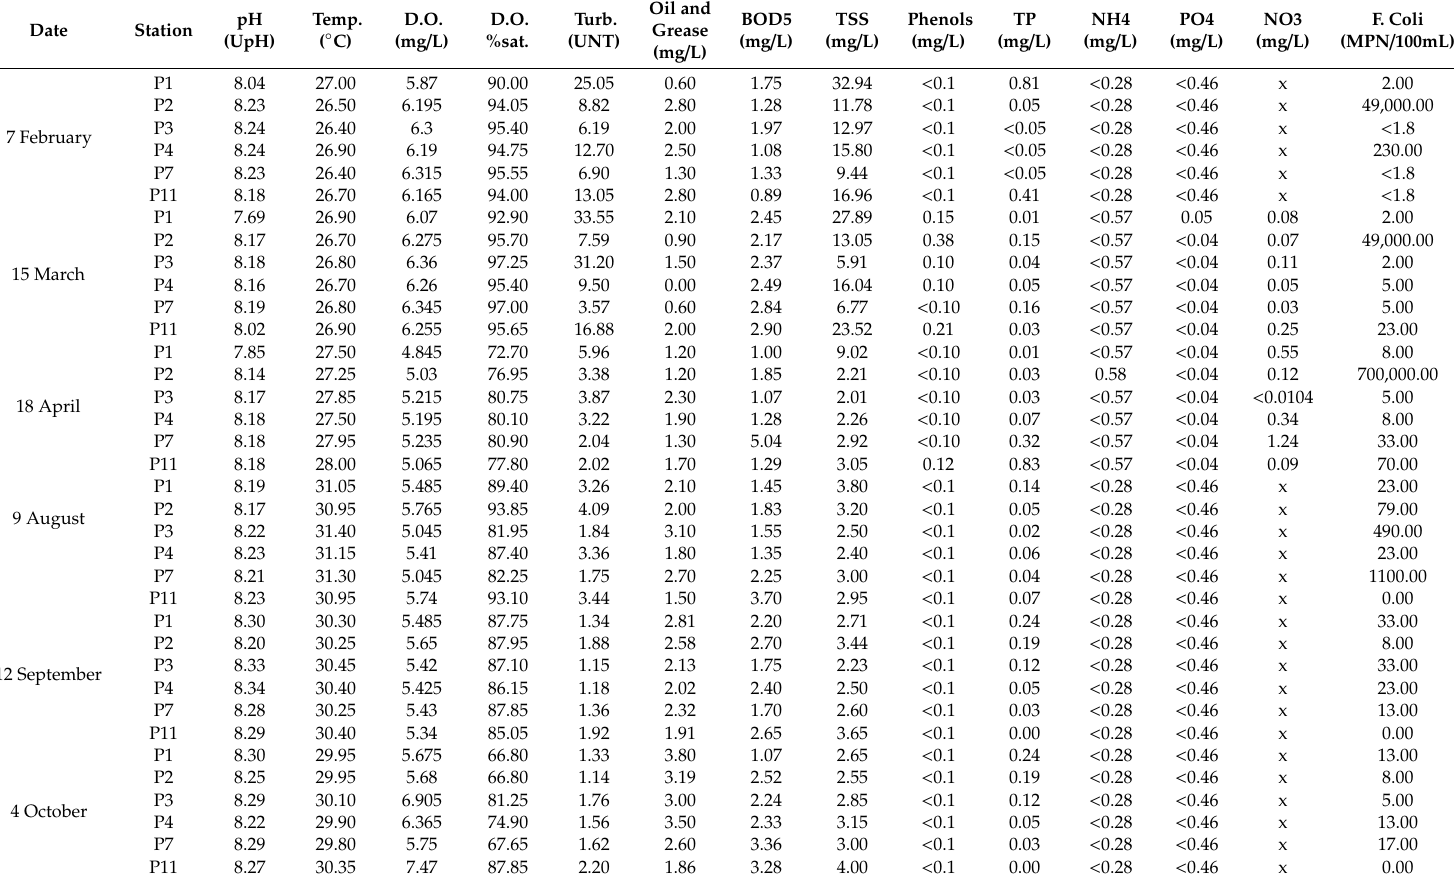
Table 5. Average values of water quality parameters along the water column in the area a ff ected by the discharge of the Cartagena submarine outfall in